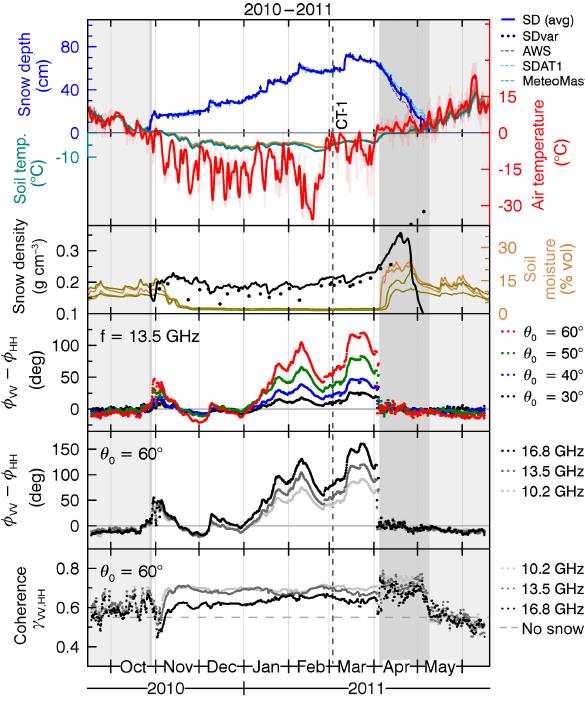
Figure 6. Winter season 2009–2010. Top panels: meteorological data measured by the sensors described in Sect. 4.6. Bottom panels: CPD and copolar coherence measured by the SSI for different inci- dence angles and frequencies. The dark gray shading shows snow melt.